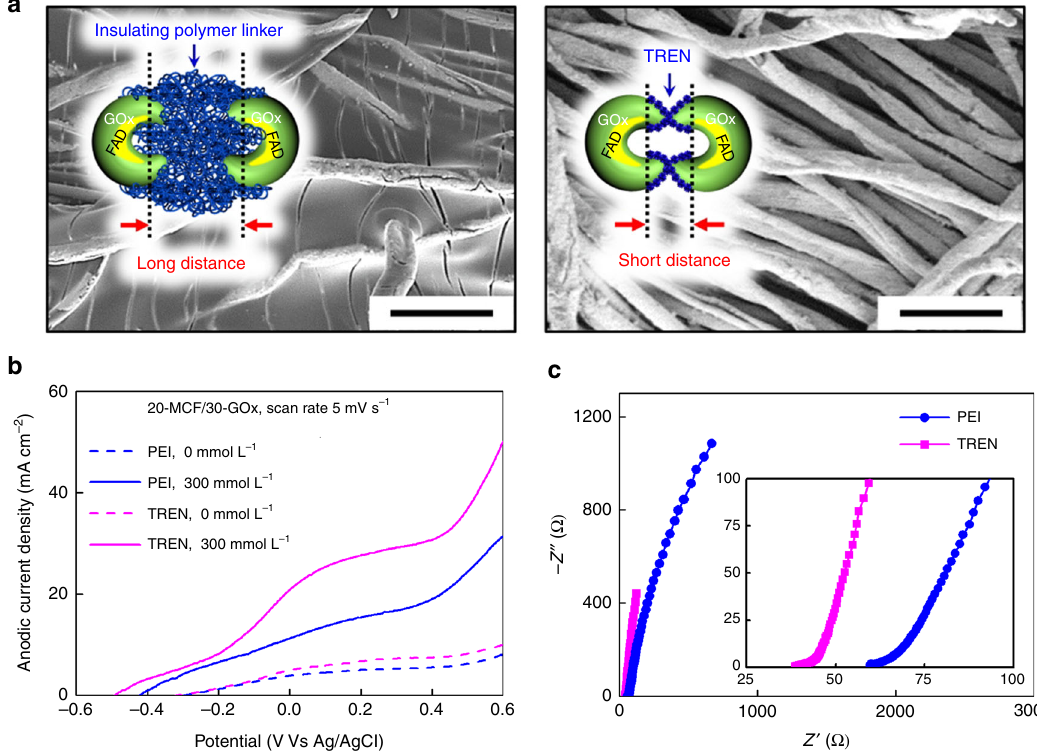
Fig. 4 Linker type-dependent biofuel cell anodes. a Field-emission scanning electron microscopy (FE-SEM) images and illustrated top views of (glucose oxidase (GOx)/poly(ethylenimine) (PEI)) 30 and GOx/tris-(2-aminoethyl)amine (TREN) m multilayer-coated metallic cotton fi bers (MCFs). The scale bars indicate 100 µ m. Inset: Schematic diagram showing the difference of the insulating polymer linker (PEI) and small-molecule linker (TREN), which is related to the internal distance (right). In glucose oxidase, fl avin adenine dinucleotide (FAD) acts as an electron acceptor. b Anodic current density curves of 30- GOx/20-MCF electrodes prepared from (GOx/PEI) 30 and (GOx/TREN) 30 in the absence and presence of glucose (300 mmol L − 1 ). c Nyquist plots for the 30-bilayered GOx/TREN multilayer-coated MCF (i.e., 30-GOx/20-MCF) anodes prepared using PEI and TREN linkers. The equivalent series